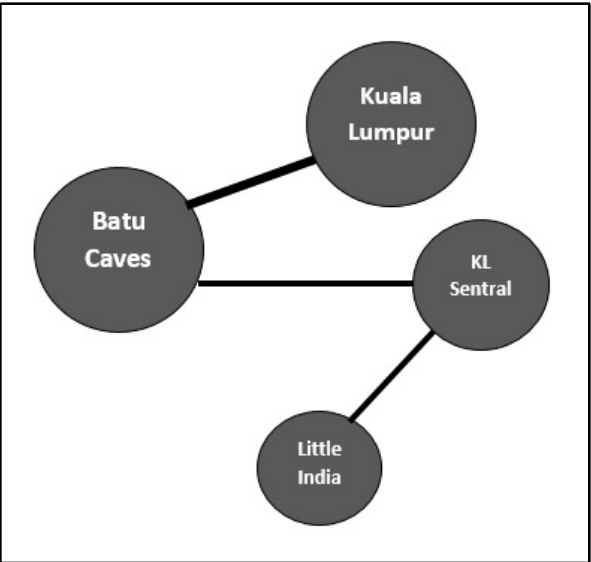
Figure 10. A typical POI graph with popular POIs and routes [46,47].